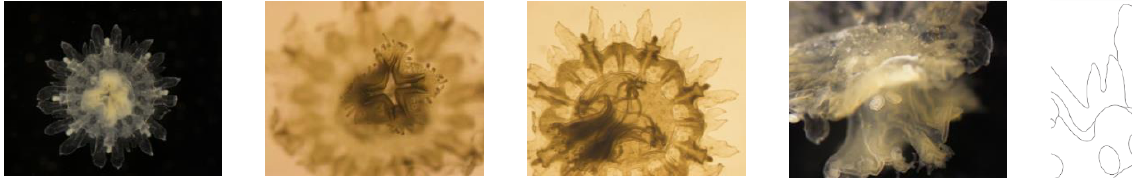
Figure 3. Stage I Ephyrae ( Stomolophus sp. 2). Without scapulets, mouth poorly developed (only mouth lips distinguisha- ble, without papillae or faintly developed), gastric system poorly developed with only velar and rhopaliar canals, four gastric filaments, lancet-shaped lappets. No velar lappets. Figure 4. Stage II Ephyrae ( Stomolophus sp. 2). Scapulets starting to develop. Mouth increasing in size and with papillae at the margin. Gastric system developing with connection of rhopaliar and velar canals forming a ring canal at the rim. Rhopaliar lappets are still lancet shaped, but becoming more rhomboid, velar lappets appearing between rhopaliar ones.